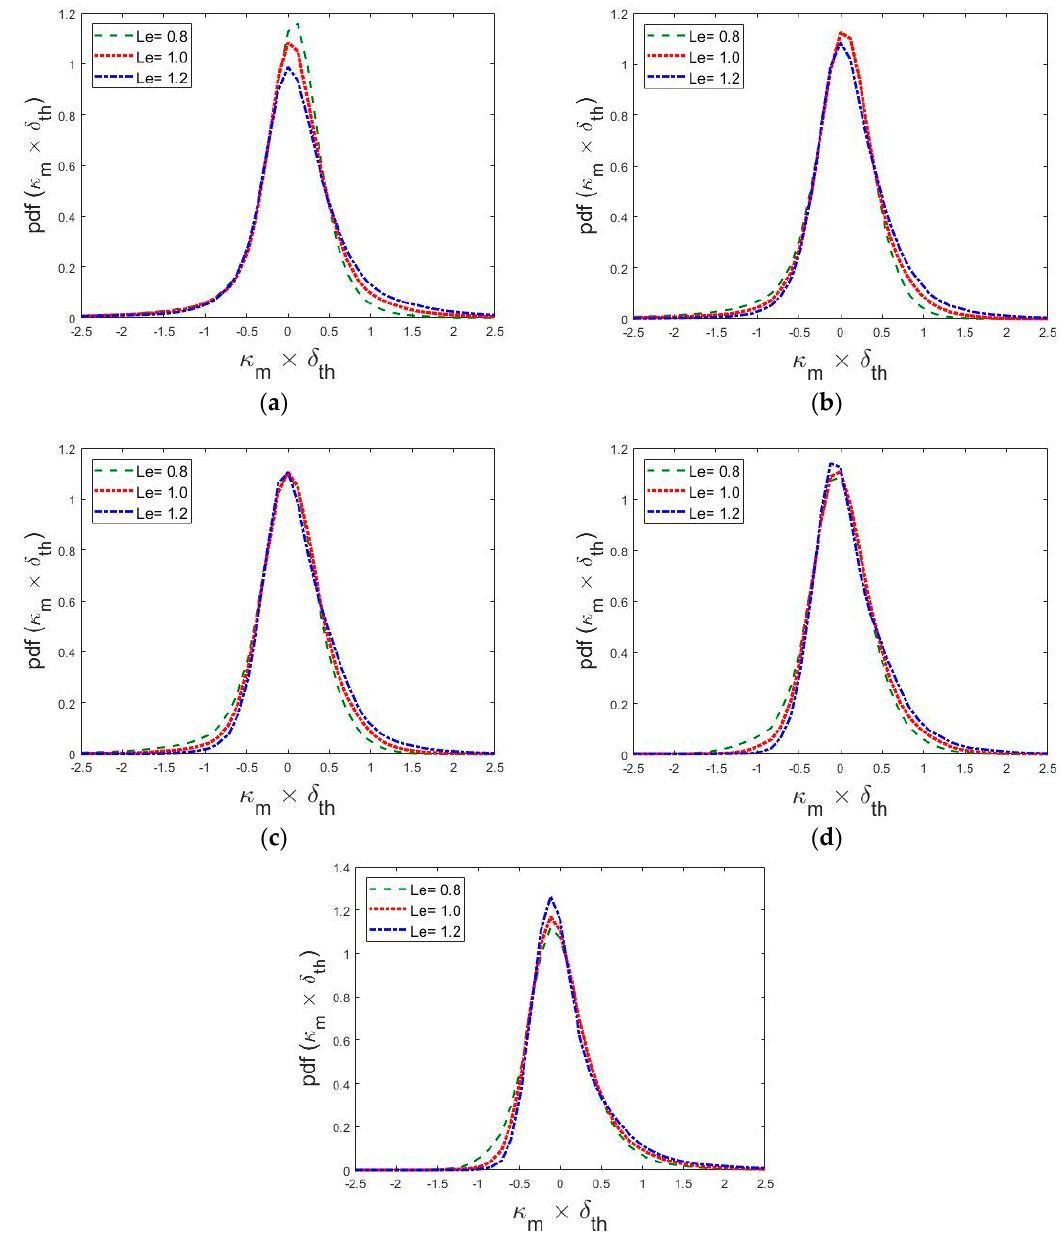
Figure 2. Probability density functions (PDFs) of κ m × δ th on ( a – e ) c = 0.1, 0.3, 0.5, 0.7 and 0.9 isosurfaces for Le = 0.8, 1.0 and 1.2.